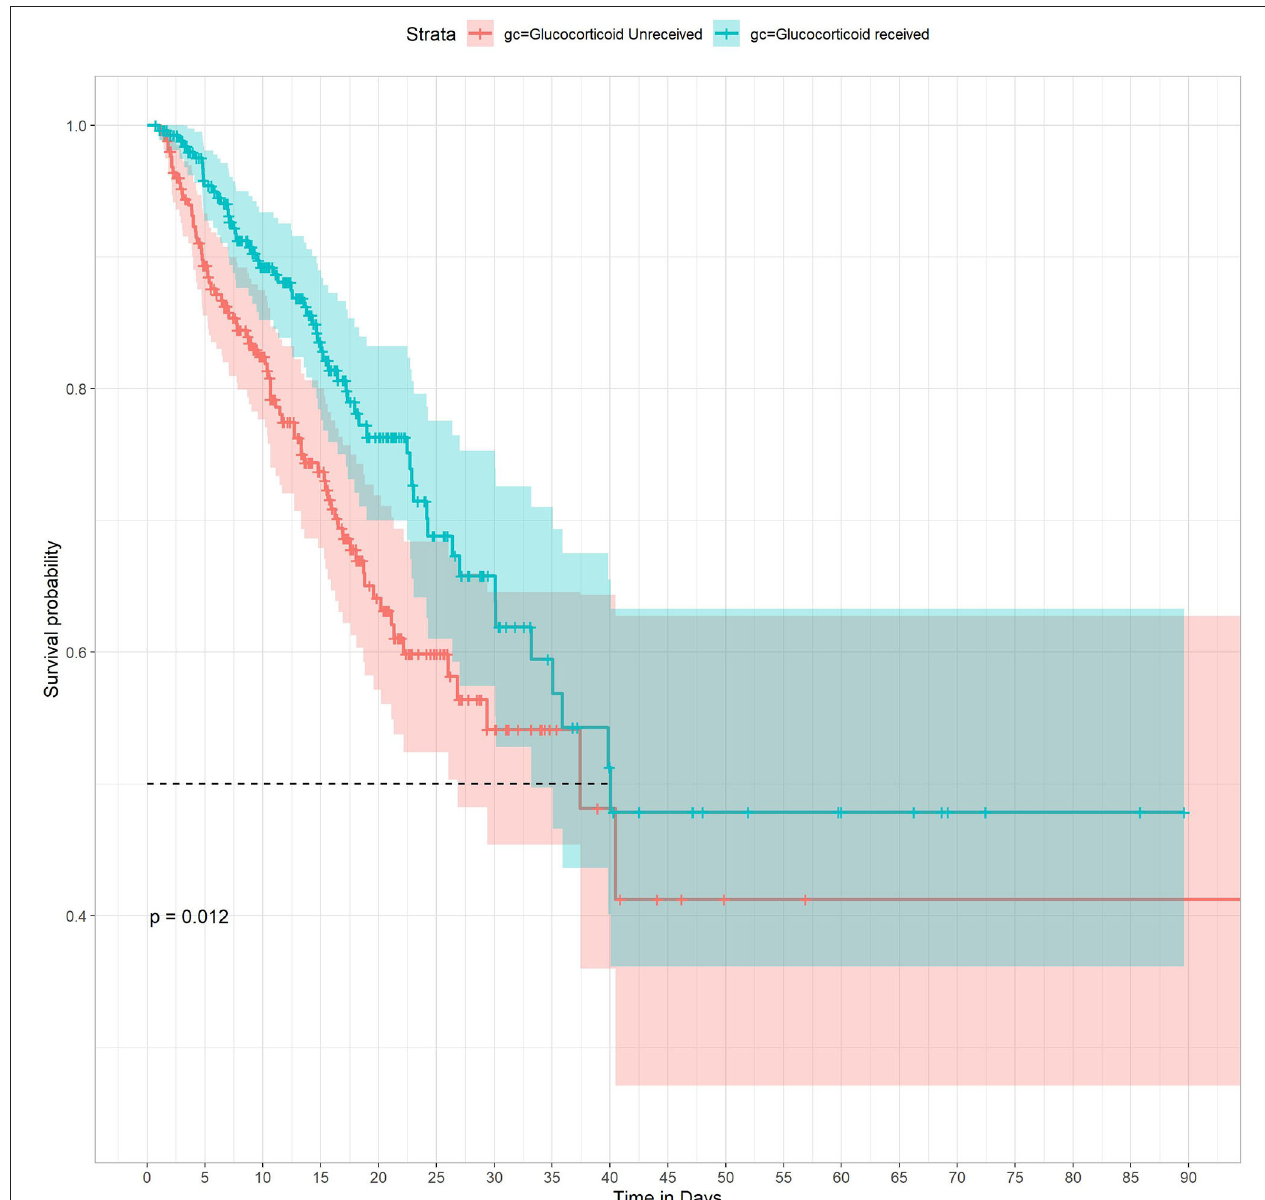
FIGURE 4 | Kaplan-Meier survival curves between groups. P -value calculated by Log-rank test = 0.012 showed GCs received group had higher survival